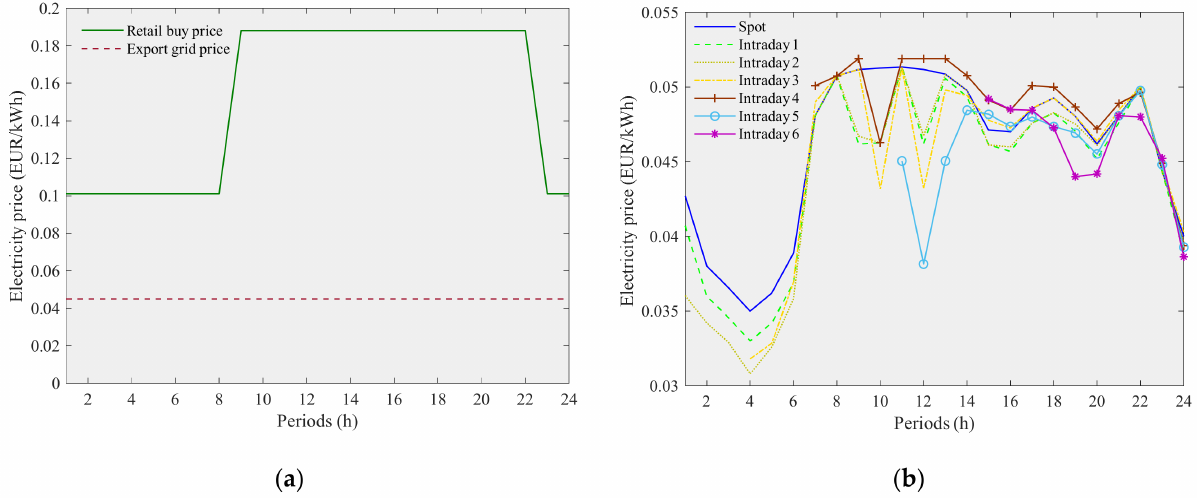
Figure 6. Electricity prices, ( a ) retail market, and ( b ) wholesale